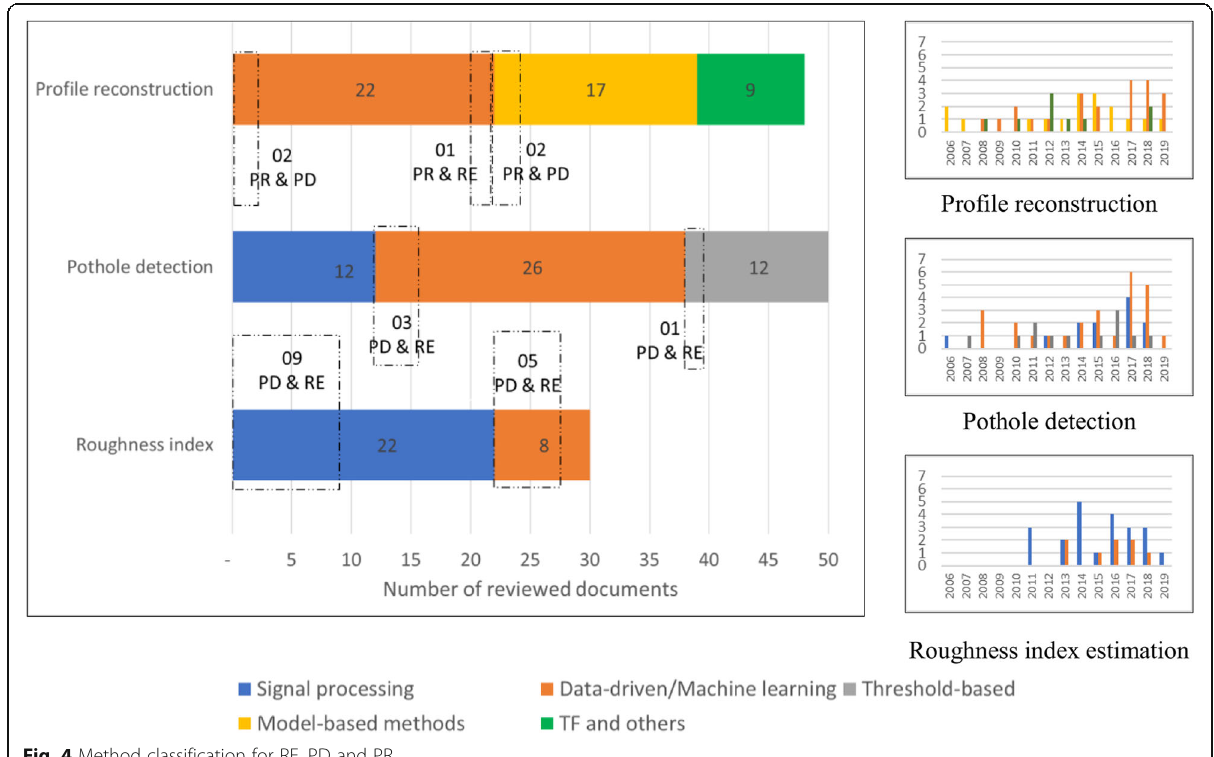
Fig. 4 Method classification for RE, PD and